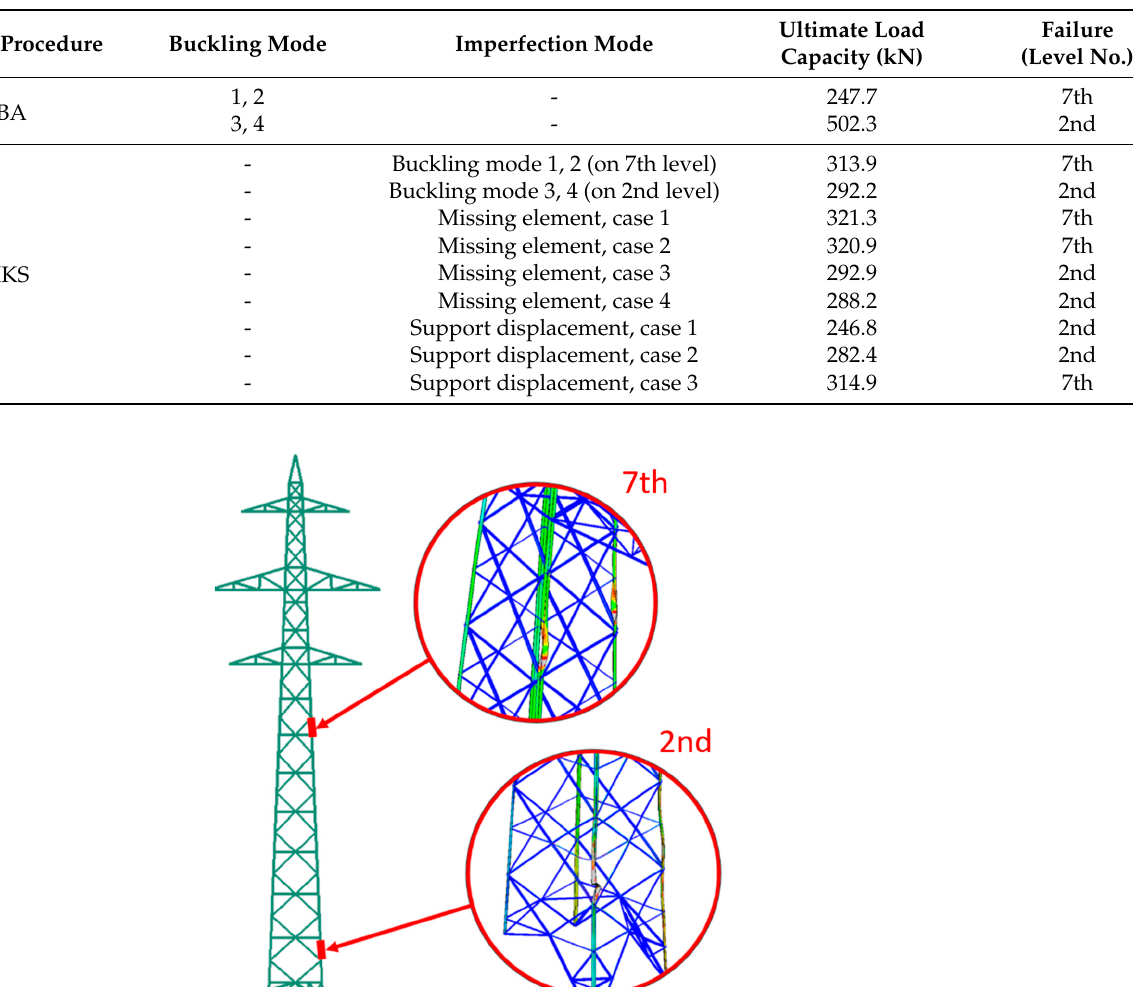
Table 7. Ultimate load capacity in LBA and RIKS analysis procedures, based on imperfections from